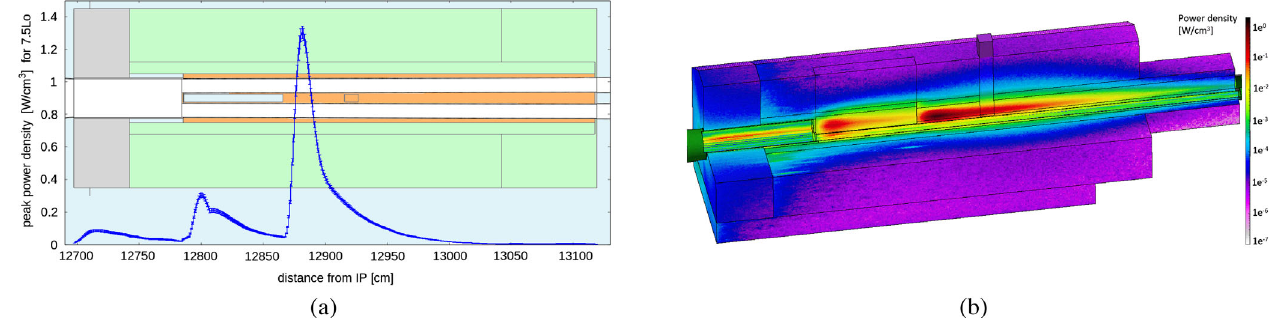
FIG. 2. Heat load originating from the collision debris calculated using FLUKA [5,6]. (a) Heat deposition peak distribution along the beam machine axis. (b) Heat deposition distribution along the transverse plane of the particles beam.